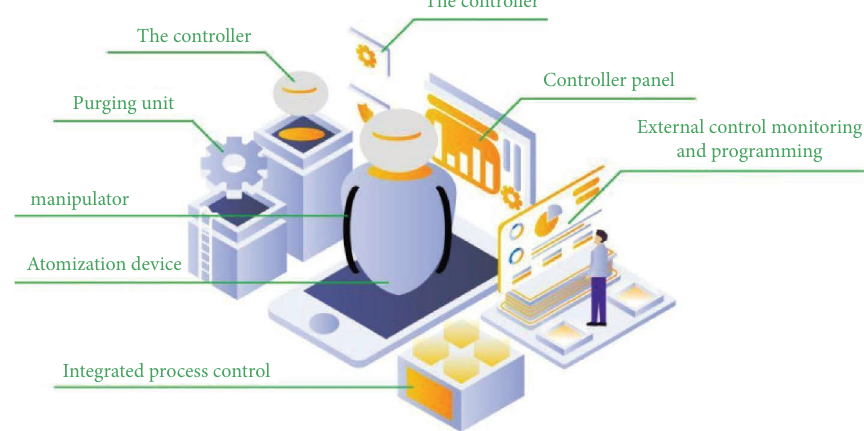
Figure 1: Robot fault